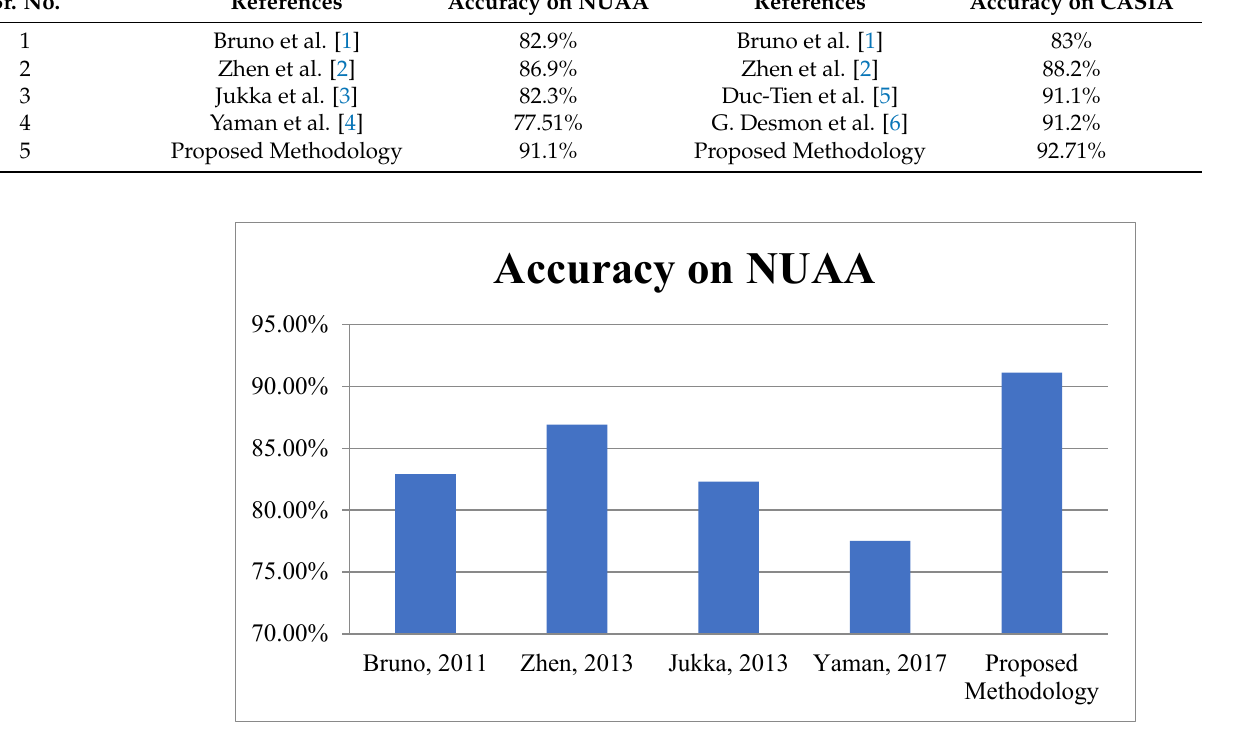
Figure 11. Accuracy Comparison for Face Spoofing on NUAA.